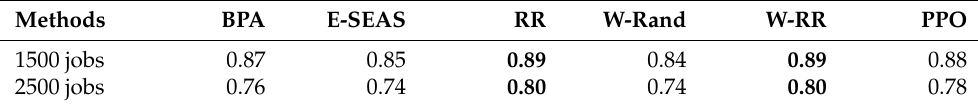
Table 1. Percentage of job completed in the fixed job environments with 120 devices.